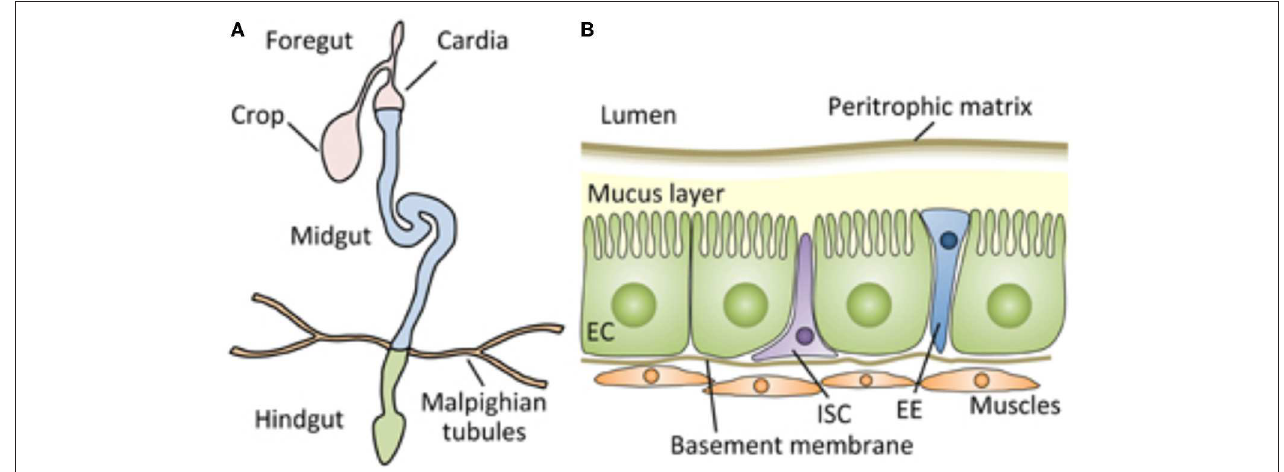
FIGURE 1 | Schematic representation of the digestive tract of the Drosophila adult, which can serve as an approximate model for the architecture of the tract of most insects, including mealworms. (A) The Drosophila gut is a tubular epithelial organ composed of a monolayer of cells surrounded by muscles. The gut is divided into the foregut, the midgut, and the hindgut, based on their developmental origin. The midgut is the main site of digestion, and most studies of Drosophila gut immunity have focused on this compartment. (B) A cross section of the adult Drosophila midgut. From Kuraishi et al. (9). Open access under the terms of the creative Commons attribution 4.0 International license.